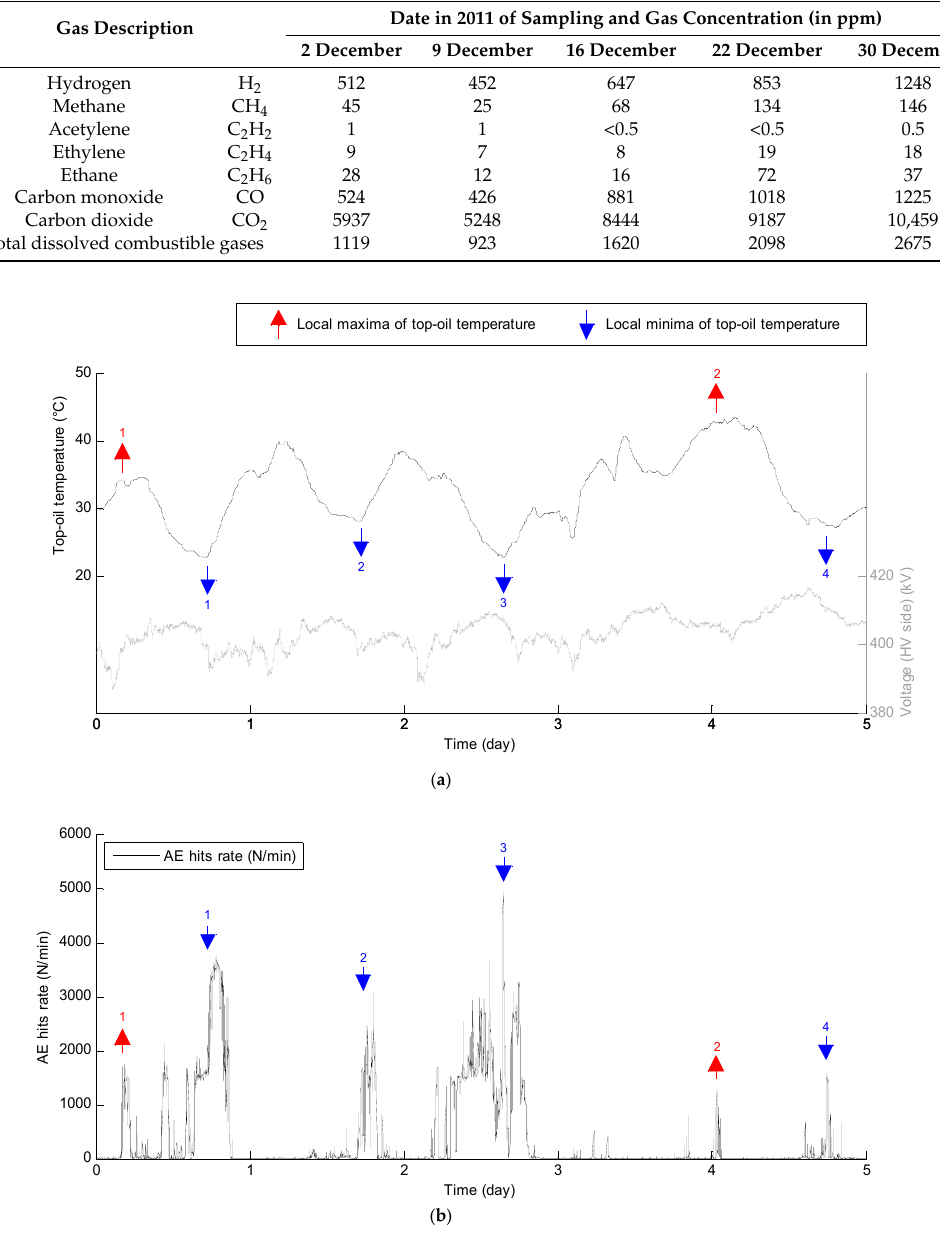
Figure 5. ( a ) Comparison of voltage, top-oil temperature (peaks and troughs are marked by arrows); and ( b ) PD activity (AE hits rate per minute) registered in the low voltage LV1 phase during five-day monitoring of a 250 MVA/400 kV/110 kV power transformer.